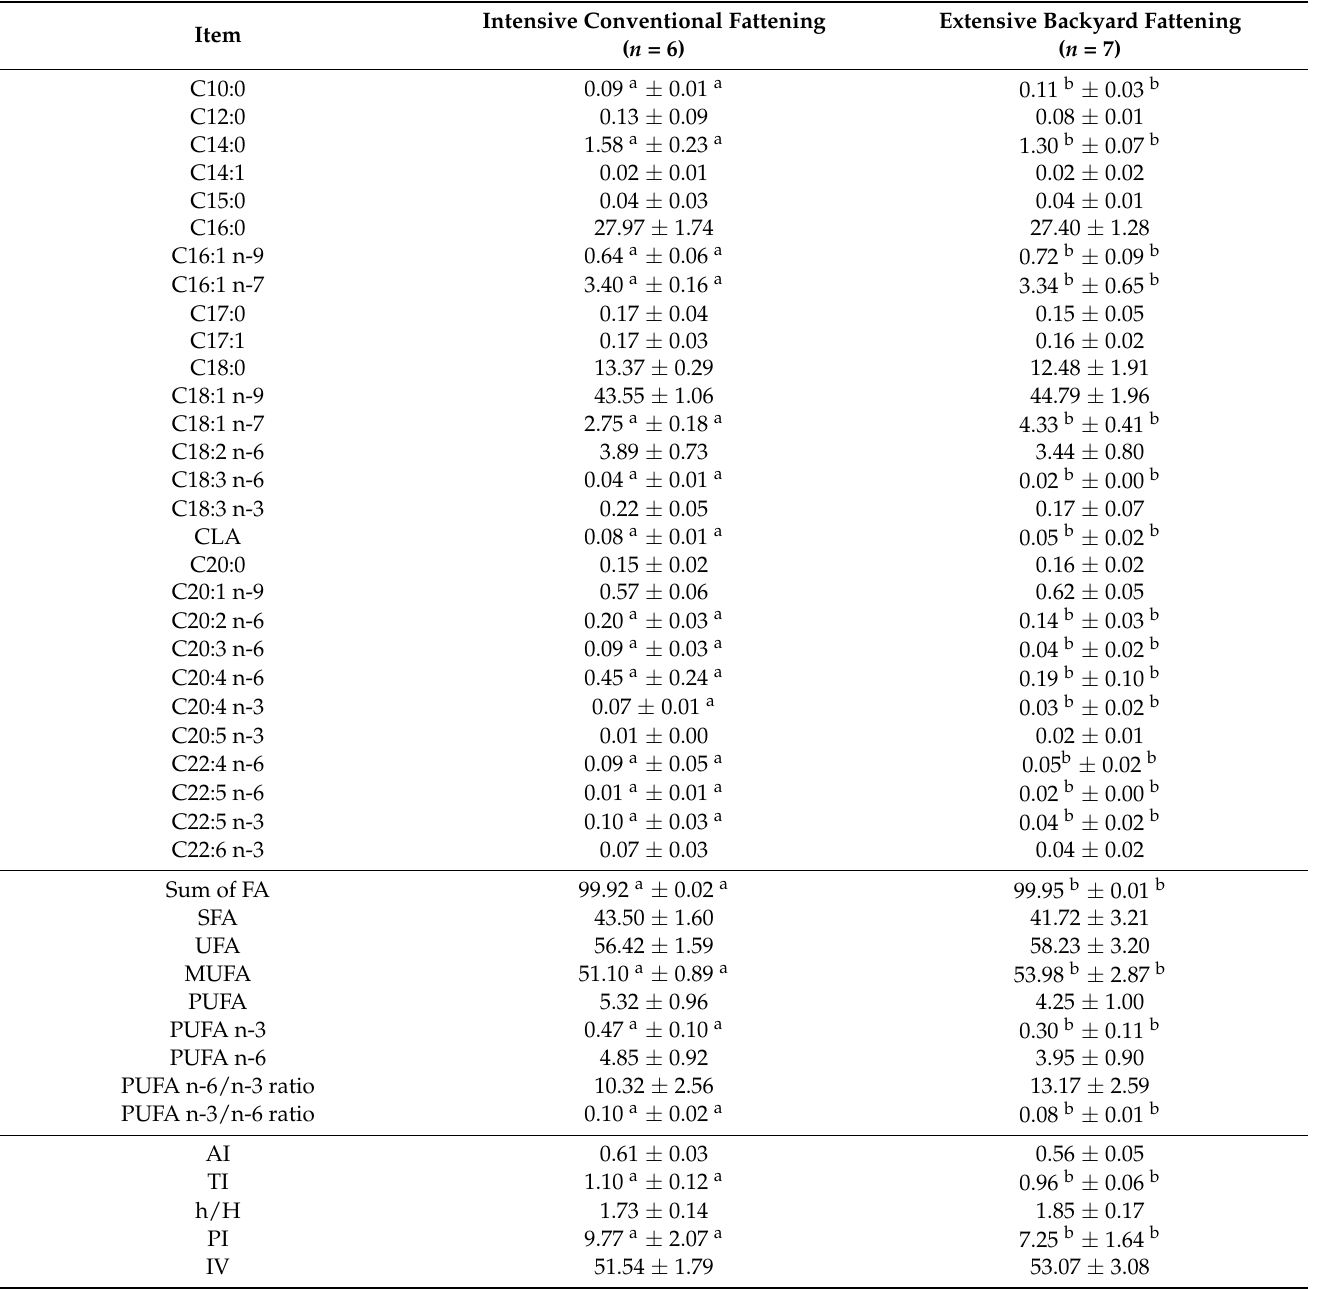
Table 5. Fatty acid composition of m.longissimusdorsi (g/100 g of estimated fatty acids) (means ± SD). Intensive Conventional Fattening Item ( n = 6)